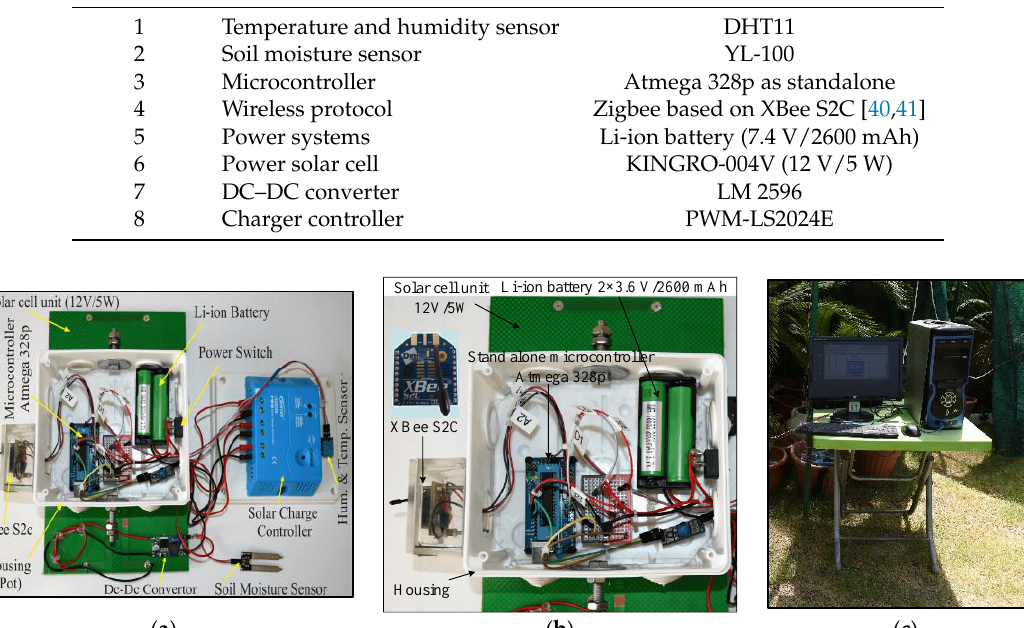
Figure 2. Hardware of the WAS: ( a ) sensor node, ( b ) router node, and ( c ) coordinator node.